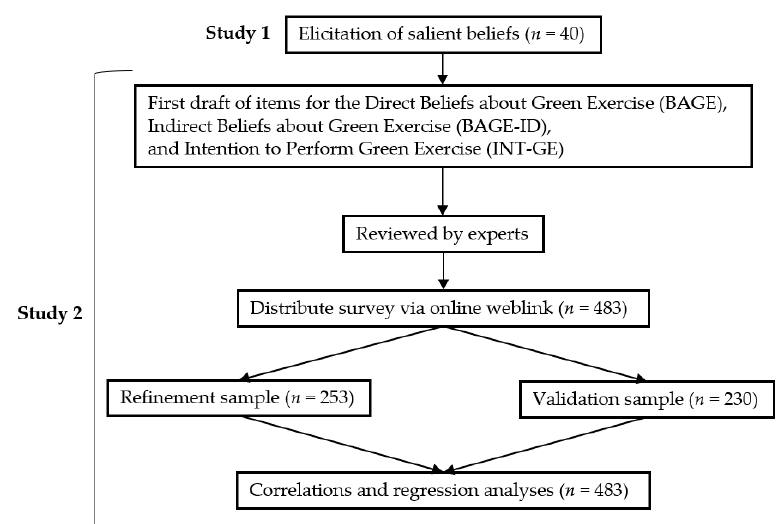
Figure 2. Phases in the construction of the questionnaires.